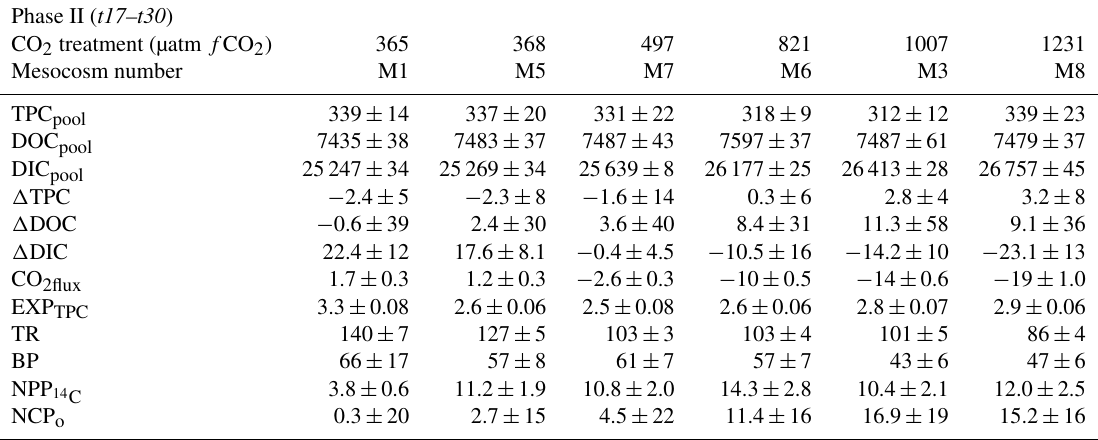
Table 2. The standing stock of total particulate carbon (TPC pool ), dissolved organic carbon (DOC pool ), and dissolved inorganic carbon (DIC pool ) at the start of phase II in mmolCm − 2 ± SE ( n = 2). The net changes in TPC ( (cid:49) TPC), DOC ( (cid:49) DOC), and DIC ( (cid:49) DIC) are average changes in the standing stocks during phase II in mmolCm − 2 day − 1 ± SE ( n = 7). Flux measurements of atmospheric gas exchange (CO 2flux ) and exported carbon (EXP TPC ) plus biological rates – TR, BP, and measured (NPP 14 ) – and net community production estimated C based on organic carbon pools (NCP o ) are all averages for phase II in mmolC m − 2 day − 1 ± SE ( n = 8, 7, 14, 5, and 14 for CO 2flux , EXP TCP , TR, BP, and NPP 14 , respectively). See Table 1 legend for further C